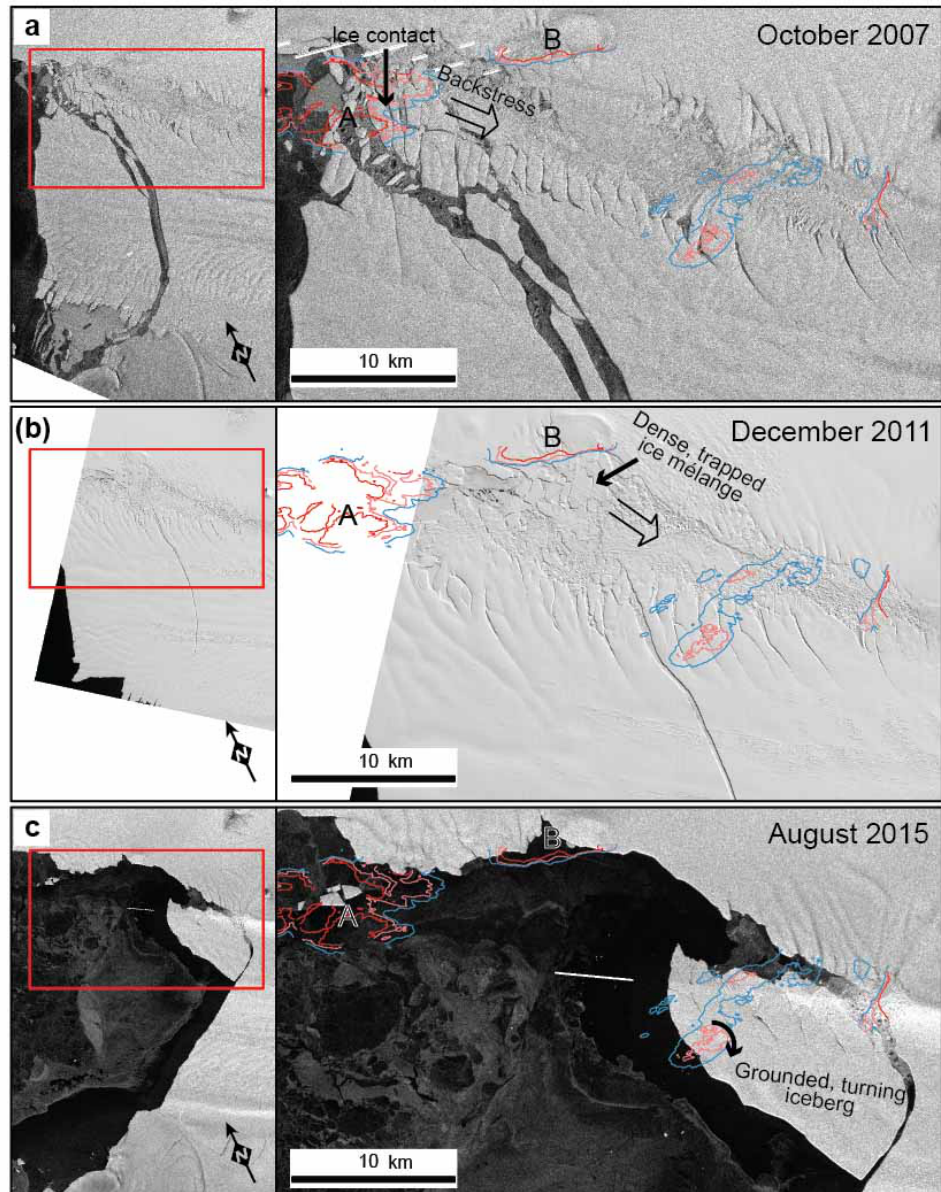
Figure 4. Time series of satellite images taken shortly before or after iceberg calving events of Pine Island Glacier that took place after 2006 when last imprints of ice contact with the bathymetric ridge were observed. Lines indicate depth contours of 350m (dark red), 400m (light red) and 450m (blue). (a) ERS image taken on 6 October 2007; note the curved calving line that is induced by back stress affecting the northern part of PIG ice shelf as a result of ice contact with the shallow bathymetry at A. (b) Aster image taken on 22 December 2011; note the curved calving line that is probably induced by dense iceberg mélange being trapped between the northern ice shelf near bathymetric high B and Pine Island Glacier. (c) TanDEM-X-SAR image (© DLR2015) taken on 30 August 2015; note the 1–2km sized icebergs stuck on shallow bathymetry in top left corner and the stationary large iceberg located on top of the bathymetric